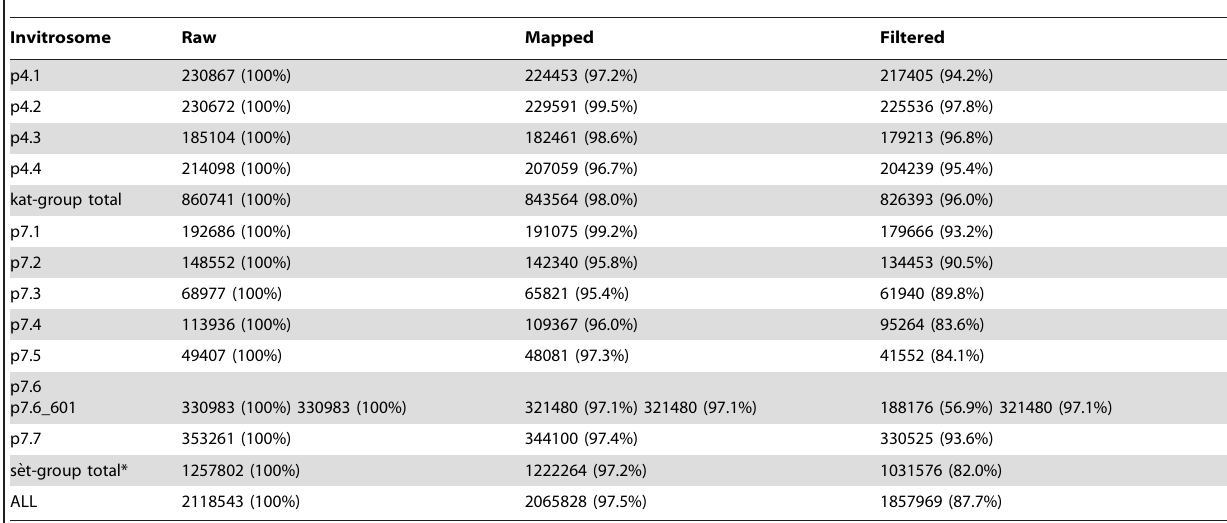
Table 2. Reads for Coverage Plots.